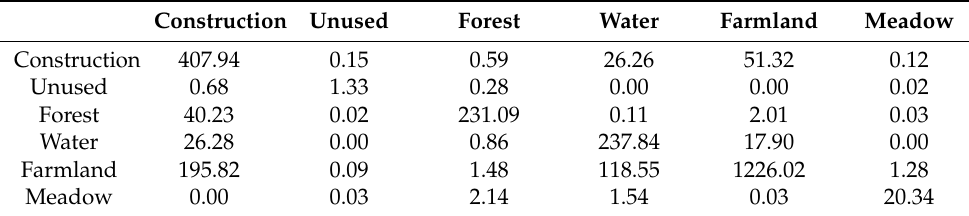
Table 3. Transfer matrices at Nanjing in the range